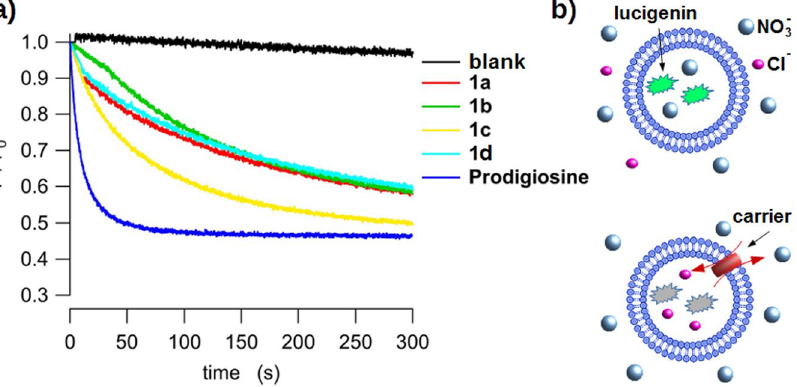
Figure 4. Chloride influx measurements. ( a ) Chloride influx measured upon addition of 1a - d and prodigiosine measured with the chloride probe lucigenin. LUV containing lucigenin in NaNO 3 were suspended in an isomolar NaNO 3 solution. NaCl was added to the external solution at the beginning of the experiment. Black trace: 1a .HCl, green trace: 1b .HCl, red trace: 1 c .HCl, blue trace: 1d .HCl, magenta trace: prodigiosin and brown trace: blank (10 µ L MeOH). Compound concentrations 50 nM. ( b ) Cartoon representation of lucigenin